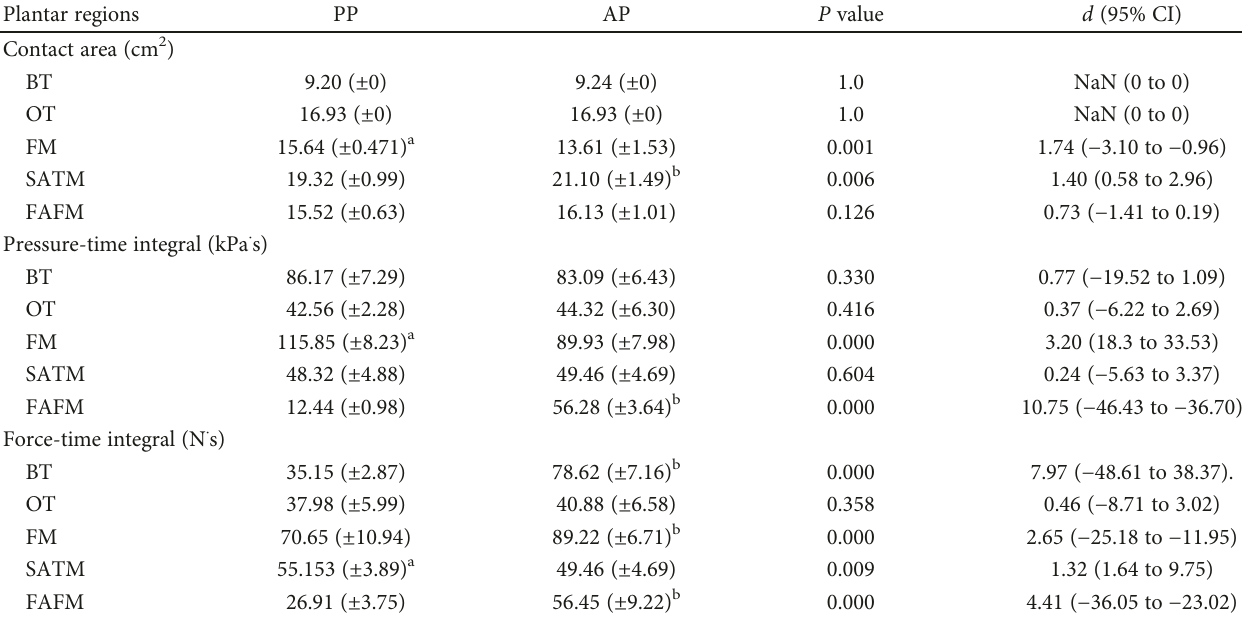
Table 1: The contact area, pressure-time integral, and force-time integral for AP and PP.